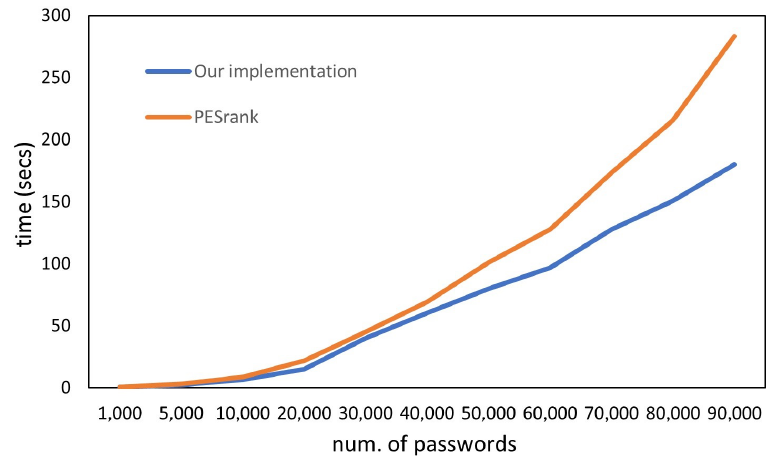
Figure 2. Our password guessability estimator component vs. PESRank (1 k–90 k). The x-axis represents the number of passwords in the input dataset, while the y-axis represents time in